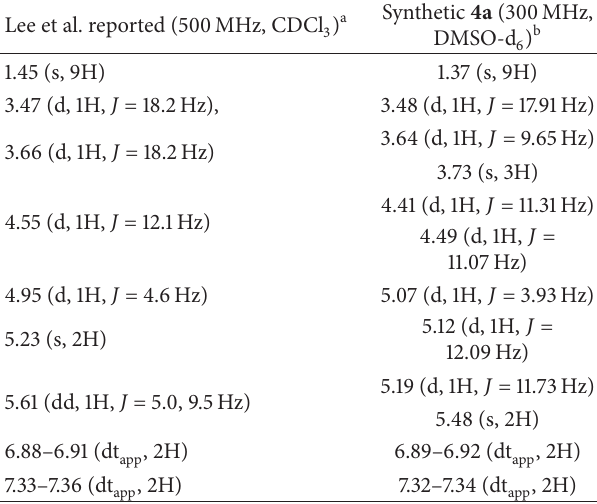
Table 2: The effect of SiO 2 and ultrasound on the yields of the Boc- ACLE.